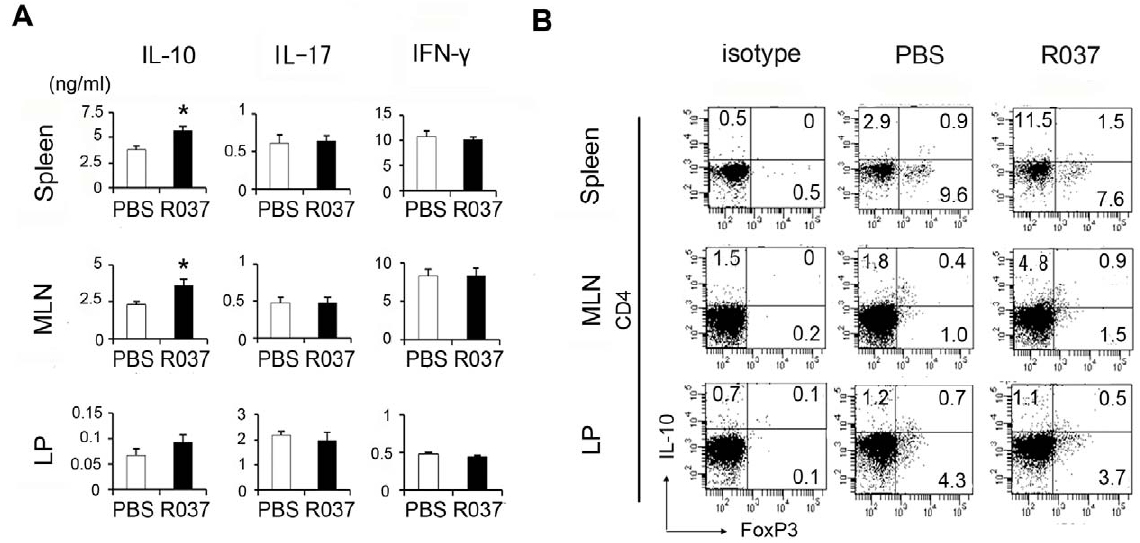
Figure 4. Administration of R037 induces CD4 + IL-10-producing T cells in mesenteric lymph nodes (MLNs) and spleen. (A) Lamina propria cells, MLNs and splenocytes were isolated from the unimmunized mice that were fed R037 for 2 weeks and after isolation, cells were stimulated with anti-CD3/anti-CD28 antibodies for 72 h in vitro. IL-17, interferon- c (IFN- c ) and IL-10 in the supernatants were assayed by ELISA. For lamina propria, each bar indicates mean + SEM of triplicate samples from 2 mice in each group. For MLNs and splenocytes, each bar indicates mean + SEM of 8 mice in each group. Data are representative of more than three independent experiments for 8 mice each. * p # 0.05 (B) Lamina propria cells, MLNs and splenocytes were isolated from the mice that were fed R037 for 2 weeks. Intracellular staining of IL-10 and Foxp3 (B) in CD4 + T cells was analyzed by flow cytometry. Data are representative of 2 independent experiments.